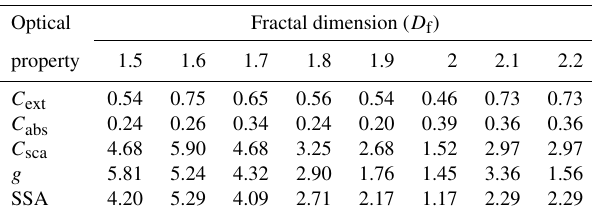
Table 2. Summary of the variability (%) in the optical properties of pure BCFAs. The variability of the extinction cross section C ext , absorption cross section C abs , scattering cross section C sca , asym- metry parameter g , and single-scattering albedo (SSA) is shown for a fractal dimension ( D f ) between 1.5 and 2.2. For each case, the resultant variability is an average of the sizes of 100, 250, 500, and 1000nm. Optical Fractal dimension ( D f )